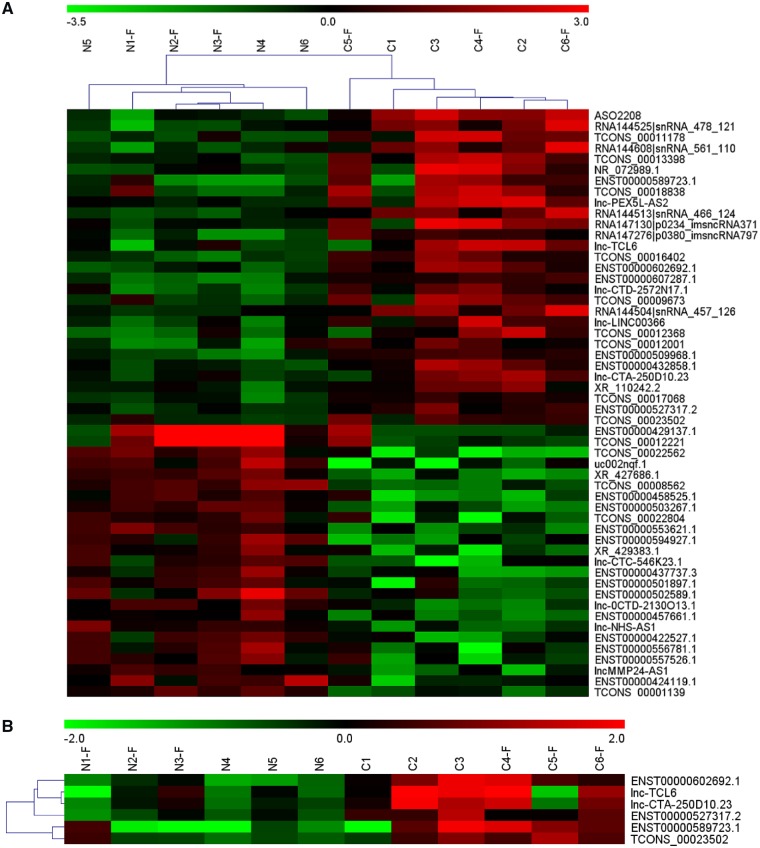
Microarray analysis of candidate lncRNA biomarkers in two group comparisons. (A) Numerous differentially expressed lncRNAs in whole blood from HBV-related liver-cirrhosis patients compared with the healthy group. (B) According to the data summarization and analysis of the microarray, ENST00000602692.1, ENST00000589723.1, lnc-CTA-250D10.23, ENST00000527317.2, TCONS_00023502, and lnc-TCL6 had significantly higher expression levels in the cirrhosis group than in the healthy group.